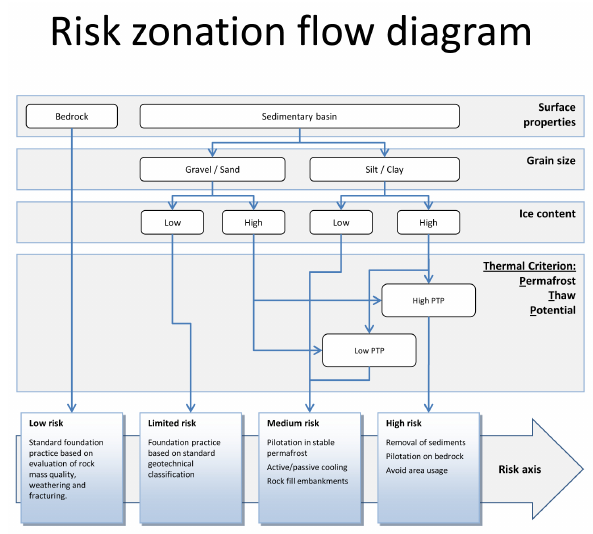
Fig. 3. Risk evaluation decision flow diagram construction per- mafrost soil or rock. Standard engineering geological main descrip- tor terms are used in descriminating Gravel, Sand, Silt and Clay. High ice content is defined as greater than porosity and high PTP is defined as greater than